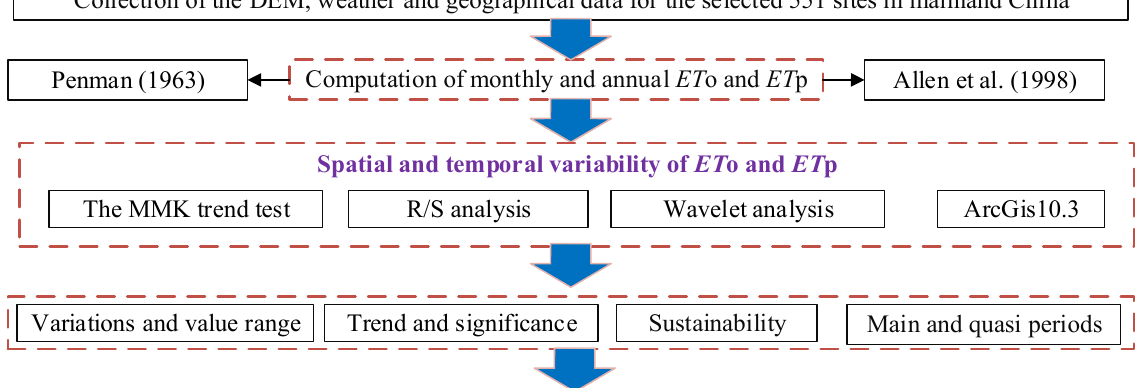
Figure 2. Flow chart of the study framework used for this research.